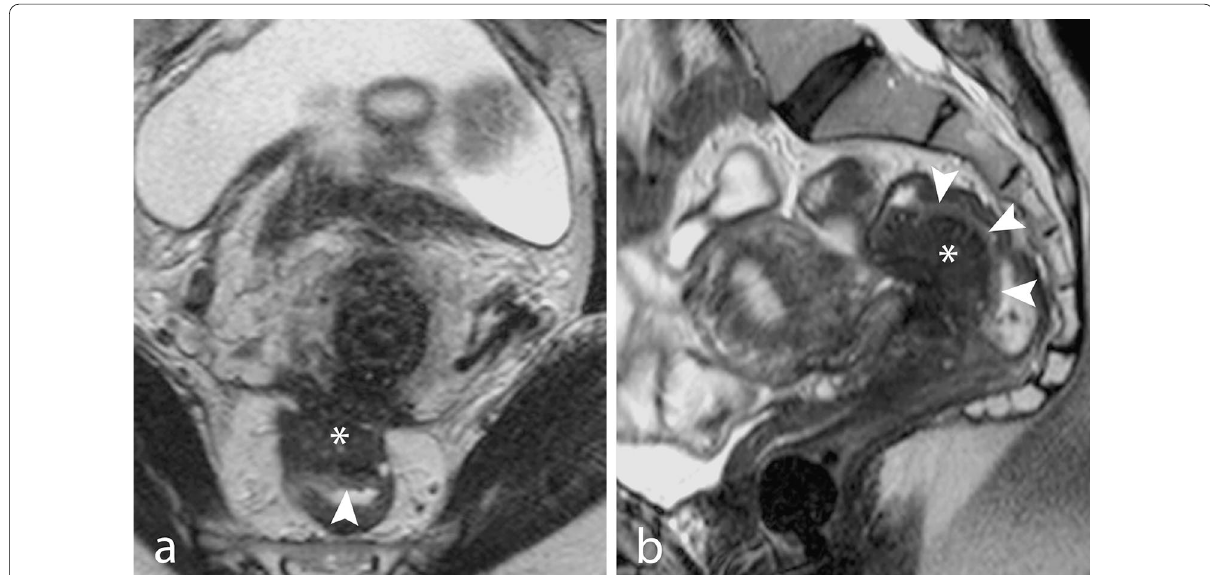
Fig. 8 DIE with rectal infiltration. TSE T2w axial ( a ) and sagittal ( b ) images. A large DIE nodule (*) infiltrates the anterior wall of the rectum. The nodule has a mushroom-cap shape with a bright peripheral rim (arrowhead) corresponding to a normal mucosa layer